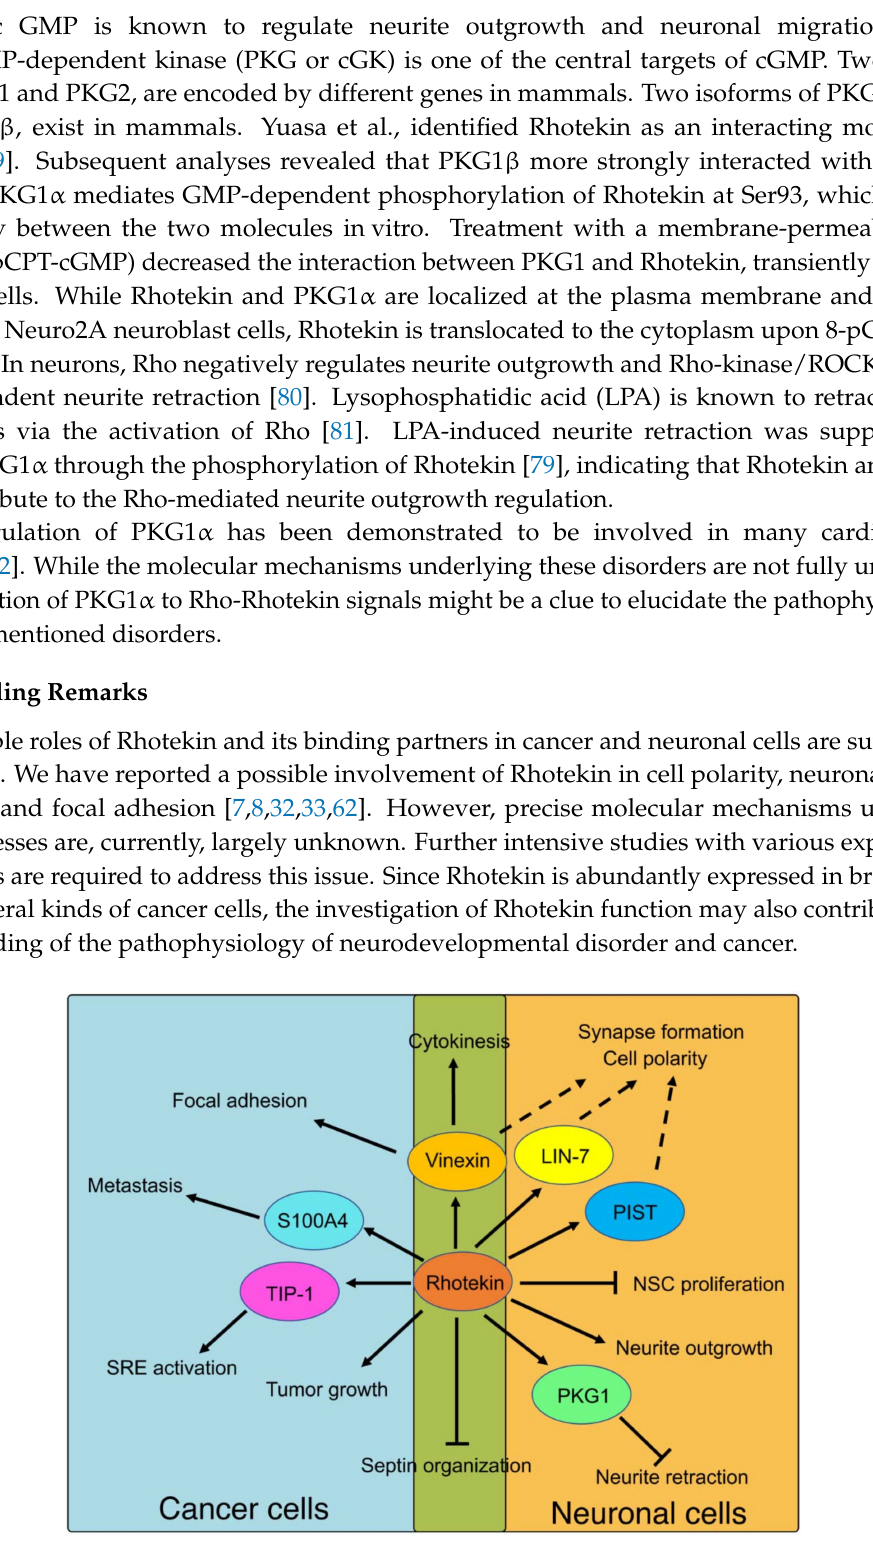
Figure 5. Physiological roles of Rhotekin and its binding partners. Solid lines represent events that are fully understood. Broken lines represent predicted roles that remain to be clarified. The abbreviations used are as follow; NSC, neural stem cells; SRE, serum response